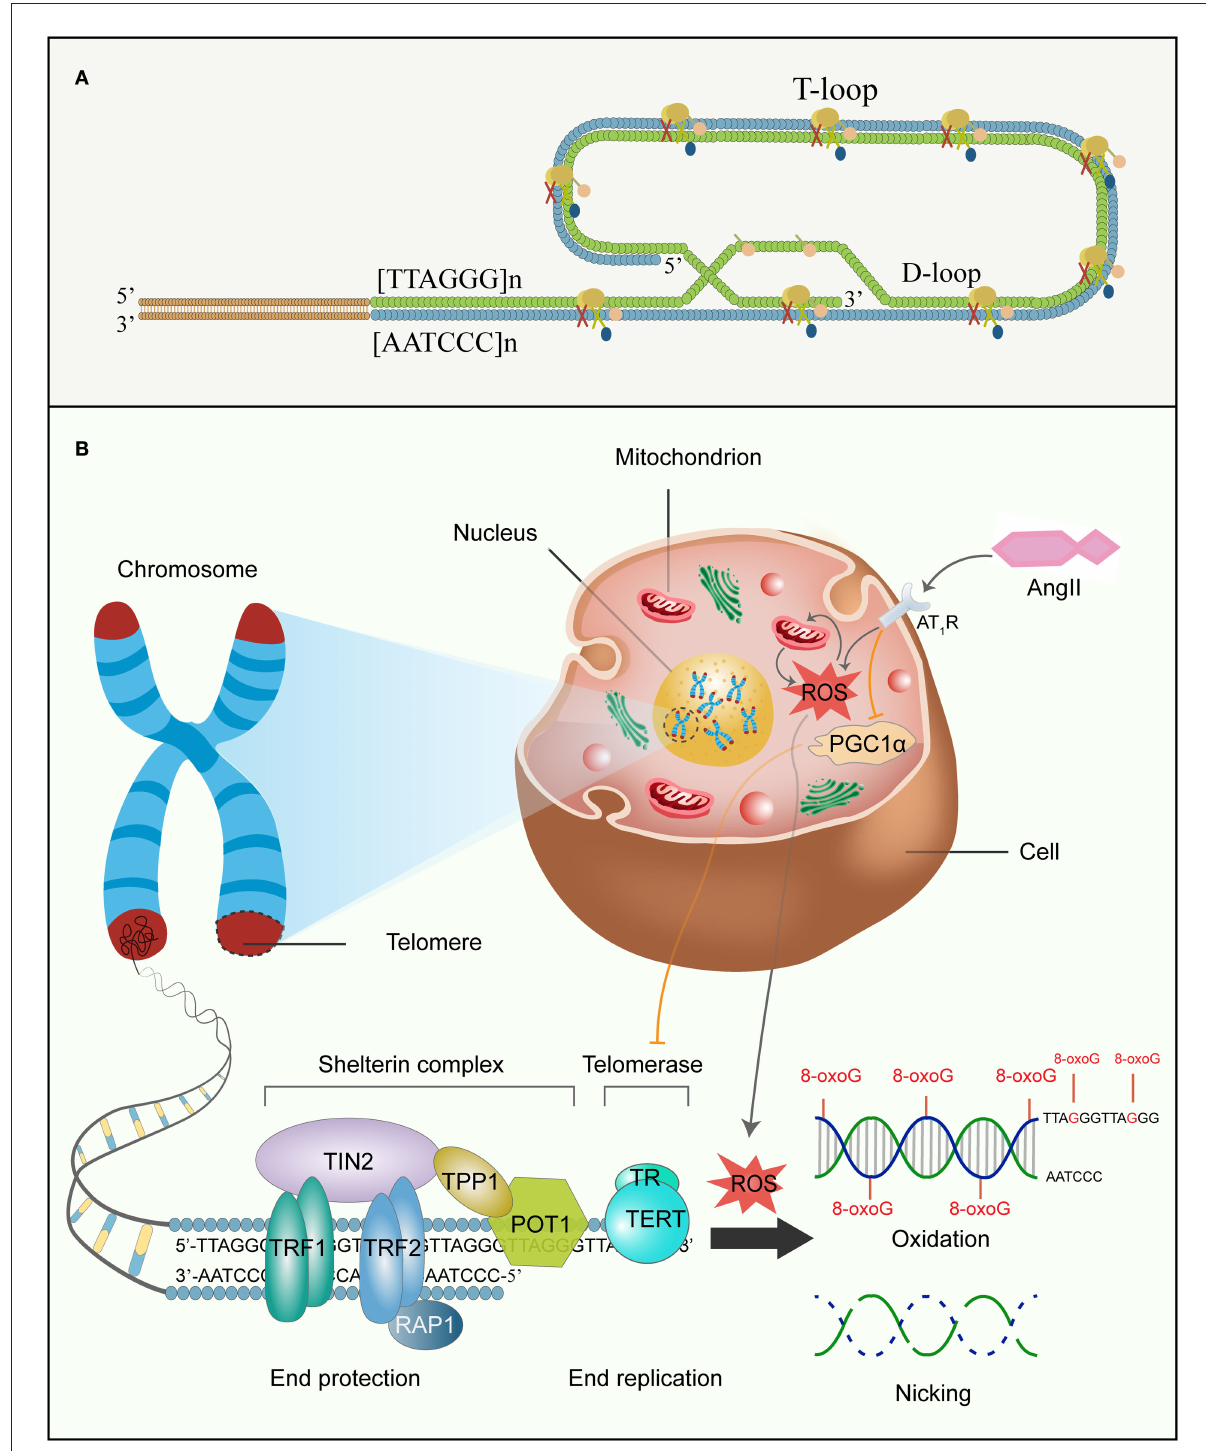
FIGURE4 Ang II and telomere attrition. (A) Shelterin complex, structure of the D-loop and T-loop at the end of telomere. (B) Ang II, telomeres, and senescence. Telomeres are at the ends of linear chromosomes and combine with shelterin multiprotein complexes to escape from DDR. Shelterin complex comprises six diverse protein subunits: TRF1, TRF2, POT1, TIN2, TPP1, and RAP1, and are involved in chromosome end protection, while telomerase is made up of TERT and TR to function as end replication. However, the G-rich chain of telomeric DNA is sensitive to ROS induced by Ang II, and further accumulates 8-oxoG damages and forges high frequency of single-strand breakage in the DNA backbone.